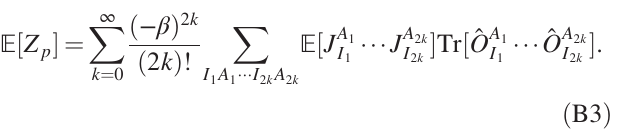
FIG. 3. (Left) An example of a chord diagram. Each gray ˆ O A l marker l represents an operator , and each black line indicates I l that the multi-indices of the two connected markers are equal. (Right) Rearrangement of the operators in the diagram, using that any two operators either commute or anticommute. The ampli- tude of the rearranged diagram equals that of the original, up to a minus sign which depends on the assigned multi-indices.